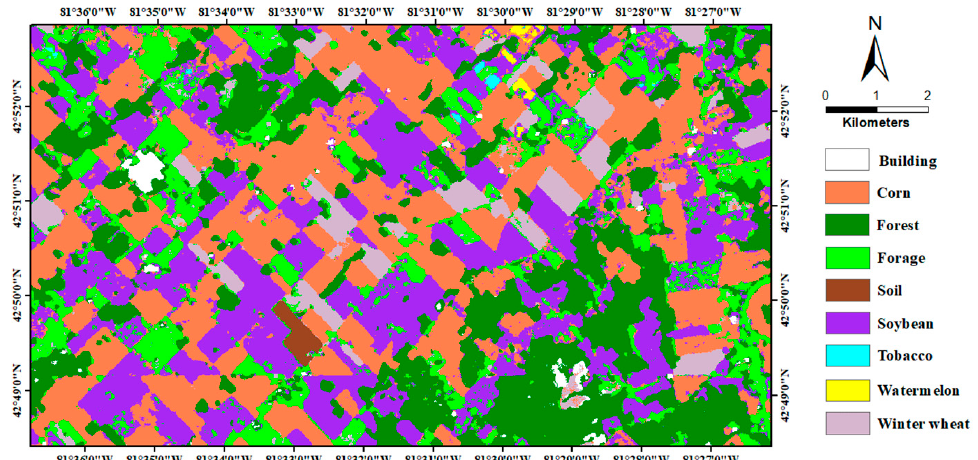
Figure 14. Classification map with the best accuracy simultaneously using optimal combination of polarimetric observables and images (OA = 94.04%).